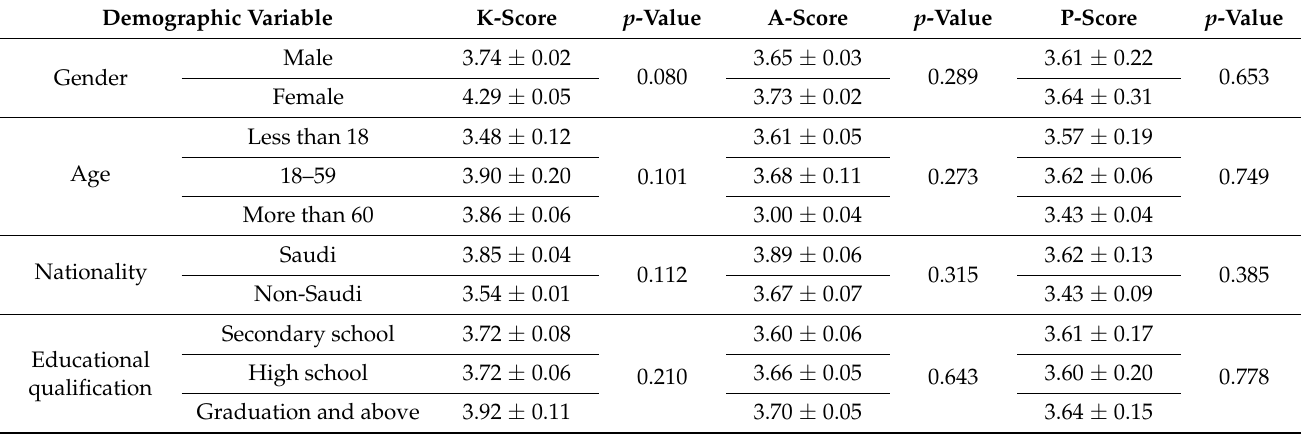
Table 5. Mean score of participants’ responses on the domains of KAP with respect to demographic